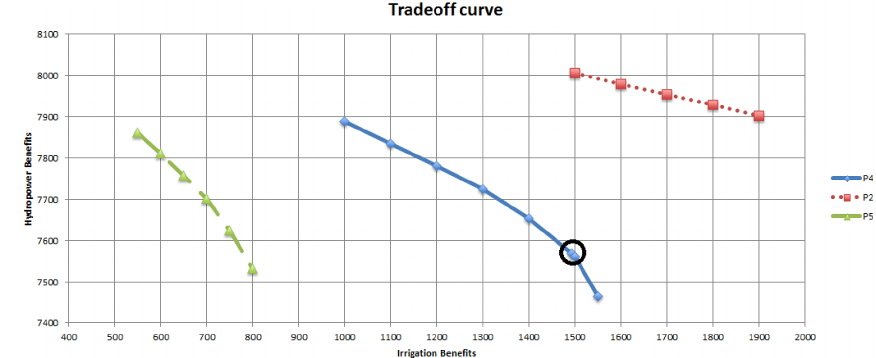
Figure 5. SHOM hydropower vs. irrigation benefit tradeoff curves for three different water values (P2, P4 and P5).